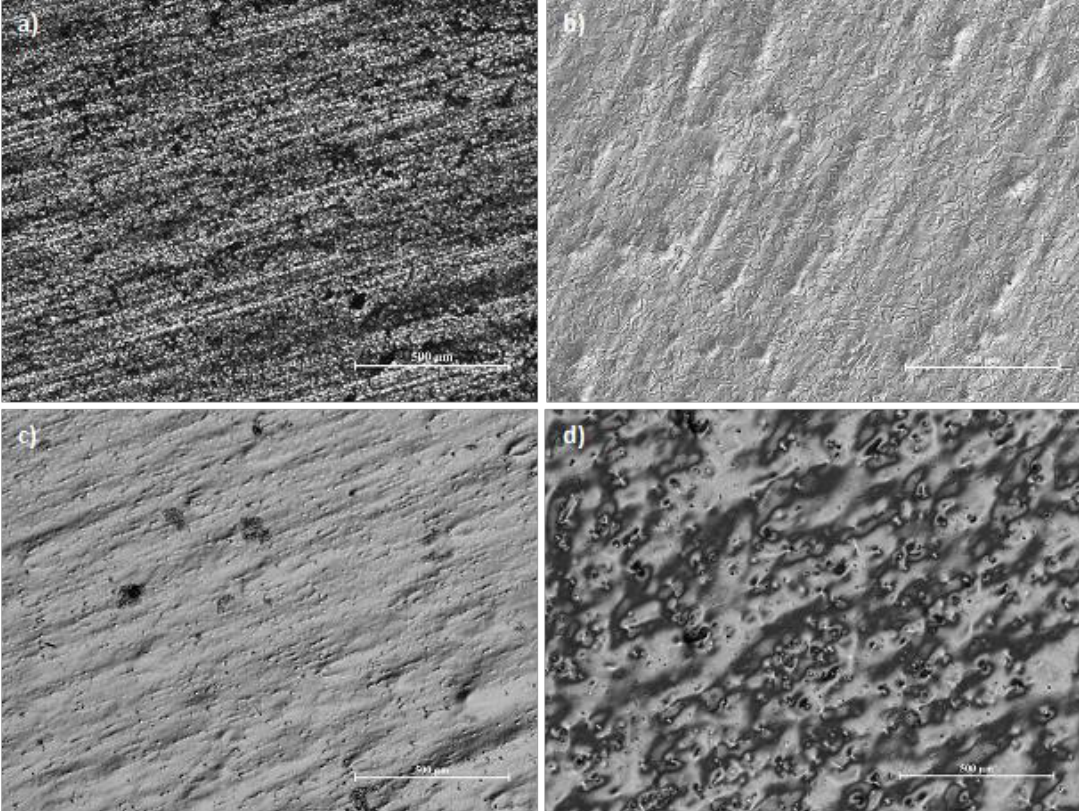
Figure 4. Metallographic photos of austenitic chromium–nickel stainless steel: ( a ) as-received, 2B surface finish, ( b ) high gloss surface after EP ( T = 35 °C, 8 A/dm 2 ), ( c ) edge of the sample with high-gloss surface after EP ( T = 55 °C, j = 4 A/dm 2 ), ( d ) internal area of the sample with orange peel effect after EP ( T = 55 °C, j = 4 A/dm 2 ).